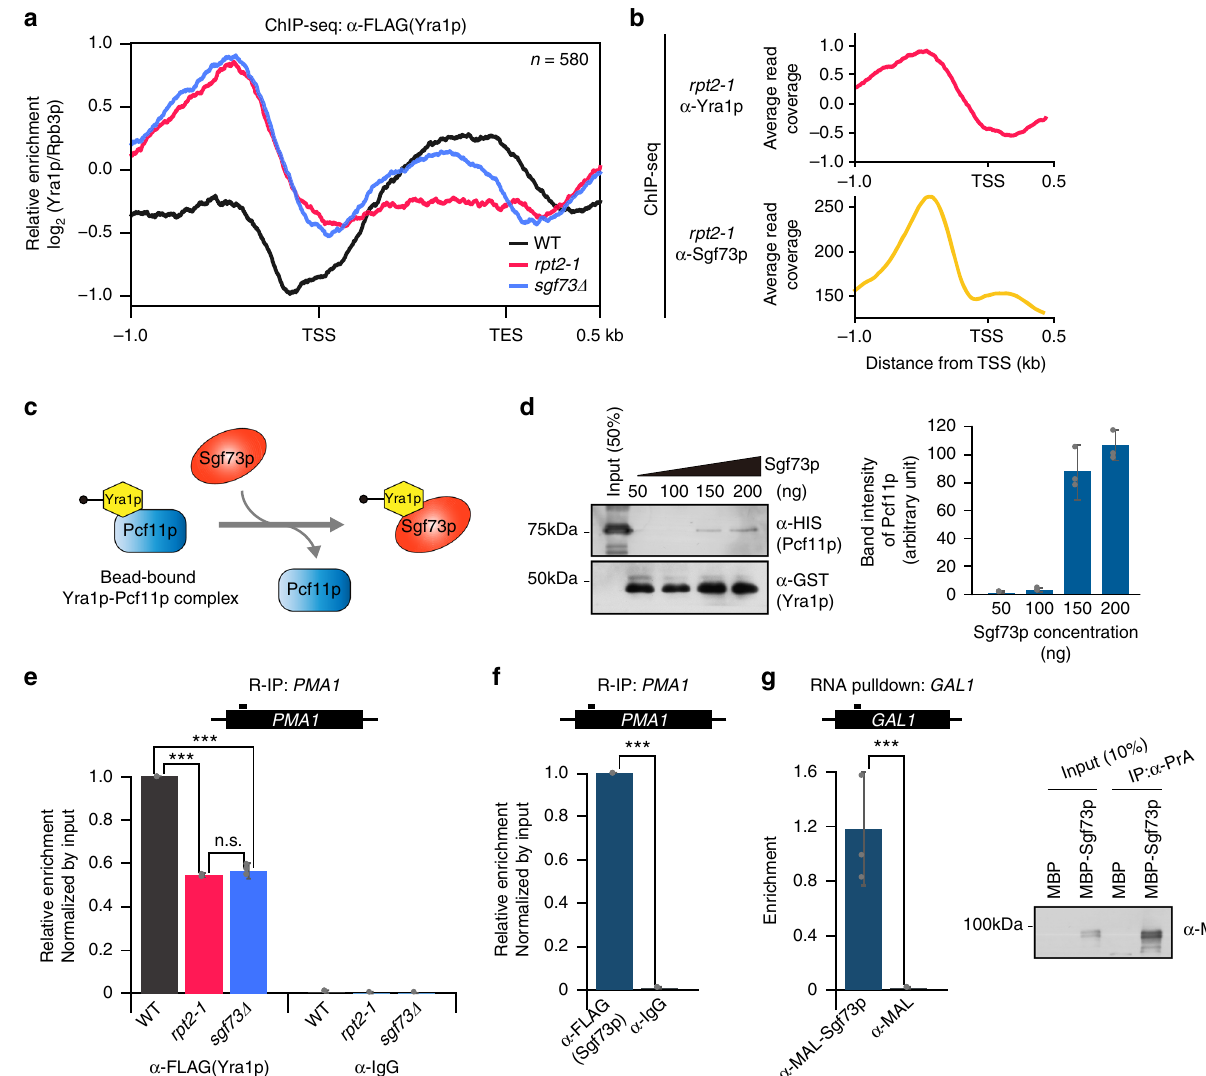
Fig. 4 Sgf73p participates in transitioning Yra1p onto nascent transcripts. a Average plots of ChIP-seq signals representing the binding of Yra1p in wildtype, rpt2-1 and sgf73 Δ cells from 1.0 kb upstream of the TSS to 0.5 kb downstream of the TES, regarding the Sgf73-peak gene set ( n = 580). b Average plots of ChIP-seq signals representing the binding of Yra1p and Sgf73p in the rpt2-1 mutant. c Schematic diagram of in vitro competition assay between Sgf73p and Pcf11p with respect to Yra1p binding. The Yra1p-Pcf11p complex was immobilized on GST sepharose beads. After a brief wash, Sgf73p was added and the amount of released Pcf11p in supernatants was assessed by Western blotting. d (Left panel) Western blotting of an in vitro competition assay performed between Sgf73p and Pcf11p ( α -HIS) with respect to the binding of Yra1p ( α -GST). (Right panel) Band intensity of released Pcf11p in the supernatant following the addition of Sgf73p. e R-IP-qPCR analysis of Yra1p ( α -FLAG) and control ( α -IgG) against the PMA1 transcript in wildtype, rpt2-1 , and sgf73 Δ cells. f R-IP-qPCR analysis of Sgf73p ( α -FLAG) and control ( α -IgG) against the PMA1 transcript in wildtype cells. g (Left panel) In vitro RNA-pulldown analysis of Sgf73p ( α -MBP) against the GAL1 transcript. (Right panel) Western blotting against bead-bound Sgf73p ( α -MBP). Standard deviations of all quanti fi cation data were obtained from three independent experiments and are shown by error bars; P -values were evaluated by Student ’ s t -test (* P ≤ 0.05, ** P ≤ 0.01, and *** P ≤ 0.001). kb, kilobase. TSS, transcription start site. TES, transcription end